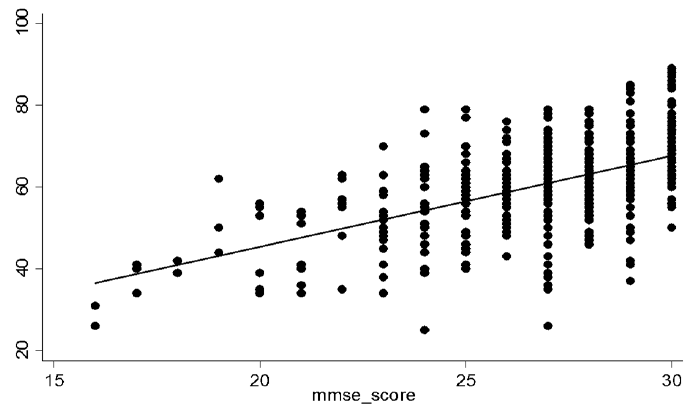
Figure 1. Scatter plot depicting correlations between the standardized MMSE-J and the Qmci-J screen.